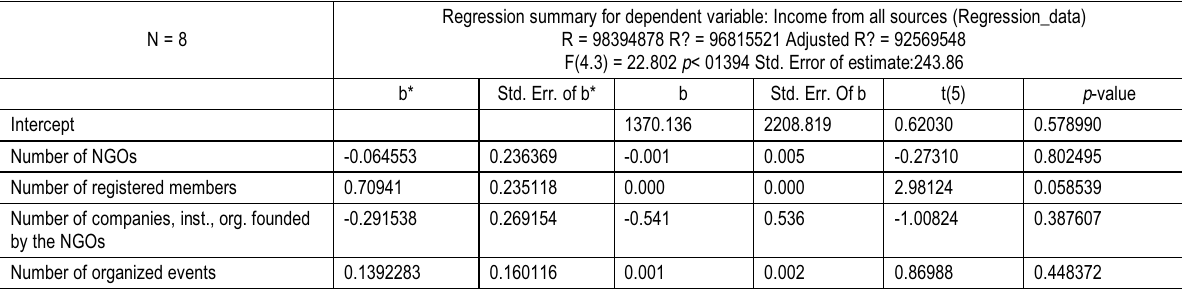
Table 8. The results of correlation and regression analysis in the Statistica system *